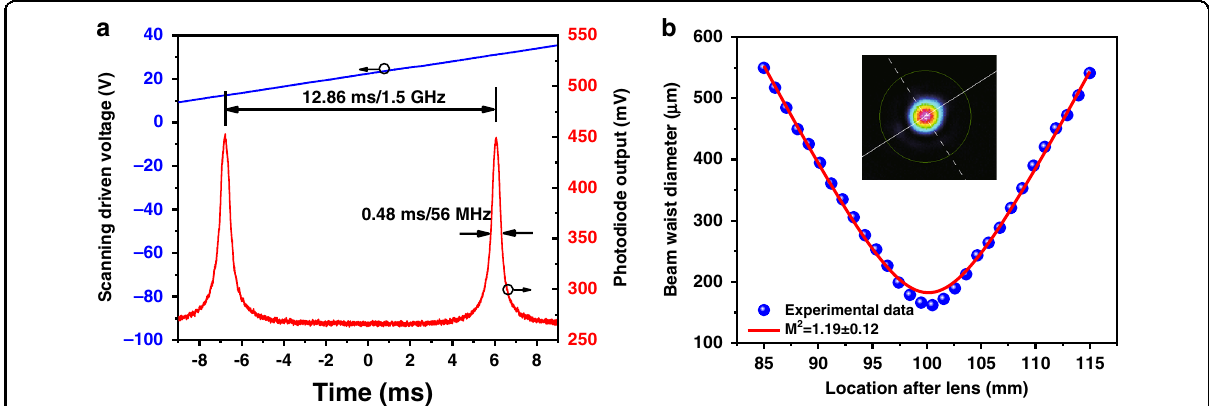
Fig. 7 Measured linewidth and beam quality of the mid-IR laser. a Line shape of the output laser measured with a scanning F – P interferometer. b Typical output laser beam quality, where the inset shows the beam pro fi le at the waist position in two